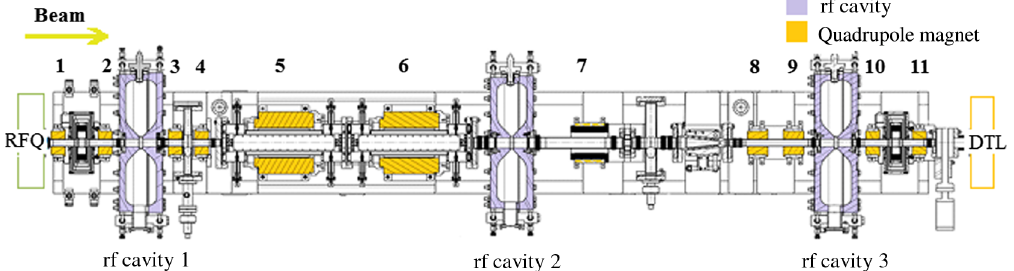
FIG. 1. Layout of the 3 MeV MEBT line [3], with knob numbers shown at the